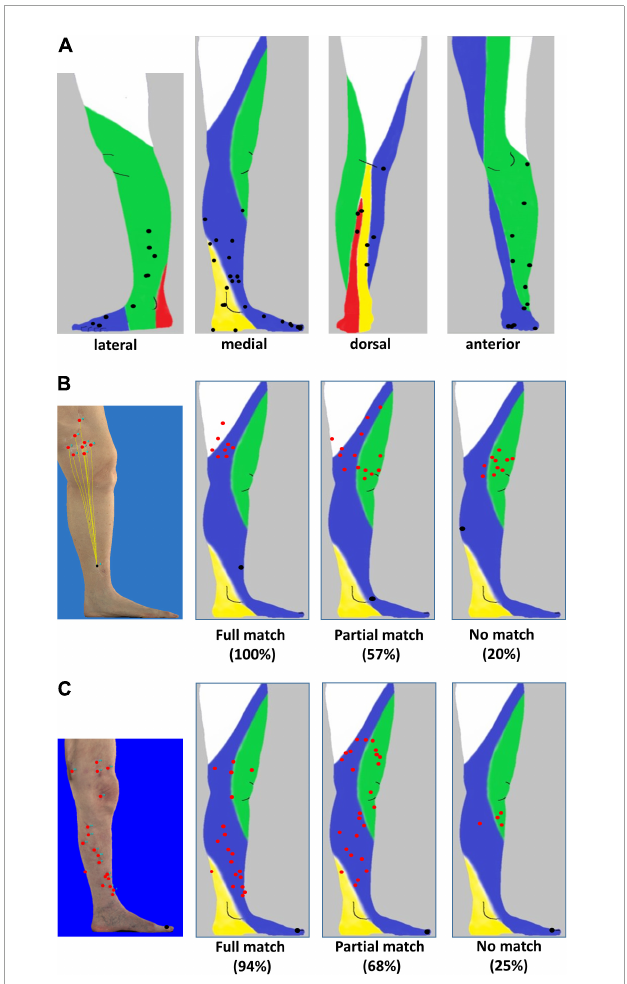
FIGURE2 Distribution of primary melanoma and in-transit metastases localized to the lower leg and foot. (A) Lateral, medial, anterior, and dorsal projection of primary melanoma (black) of 58 patients based on photographic images and mapping to distinct anatomic lymphatic drainages regions of leg: posteromedial (yellow), anteromedial (blue), anterolateral (green), and posterolateral (red). (B) Melanoma of the lower leg: three-dimensional (3D) image of a primary melanoma and corresponding in-transit metastases as well as the supposed lymphatic drainage (left image). Representative examples of individual patients with primary melanoma (black) on the lower leg with a full match of 8/8 (100%) of in-transit metastases (red) developing in the corresponding anteromedial lymphatic region (second image from the left) and metastases developing partially (8/14, 57%, second image from the right) or not predominantly within (2/10, 20%) the expected localization (right image). (C) Melanoma on the foot. Annotation of in-transit metastases (red) on a 3D photographic image (left image). Examples of representative individual patients with primary melanoma (black) and corresponding in-transit metastases (red) occurring fully, partially, or not (images second from the left, second from the right, and right) in the expected lymphatic drainage area.